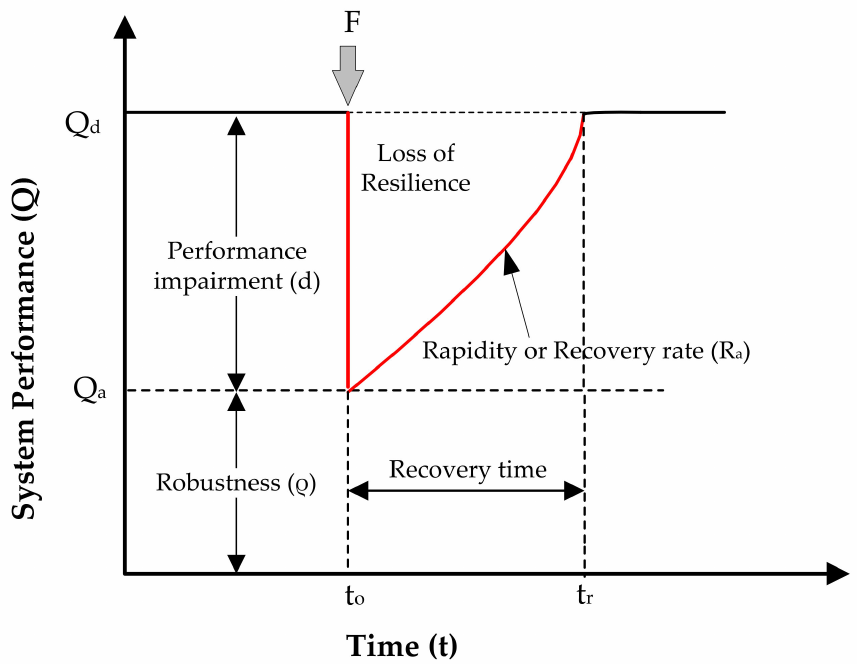
Figure 5. Schematic to measure resilience of water systems (modified from Cimellaro et al.,